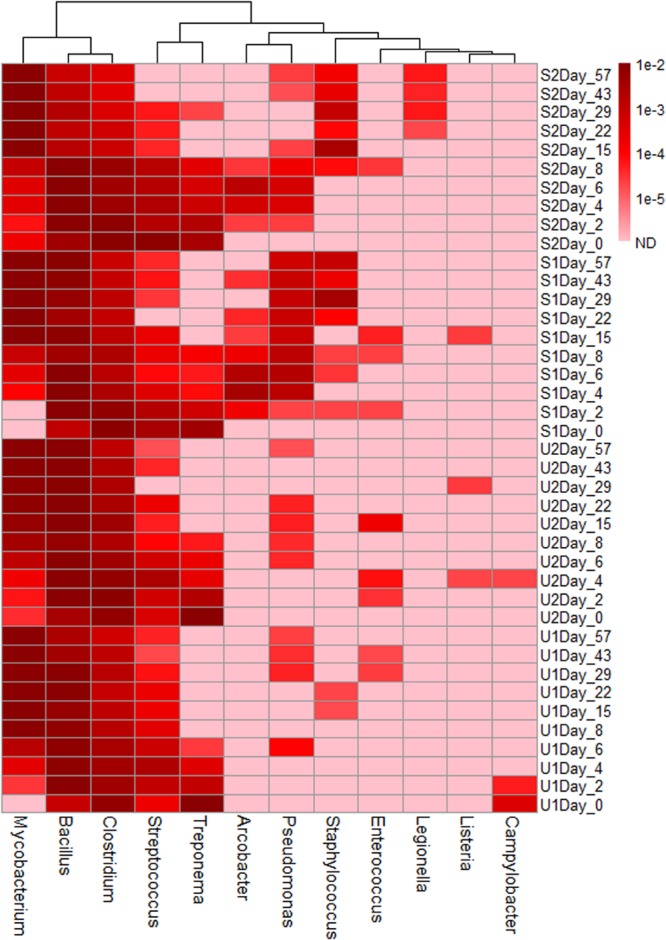
Heatmap of genera consist of pathogenic species. The abundance scale of heatmap ranged from 10-2 to non-detected (ND). Pink color in the heat map indicates ND.